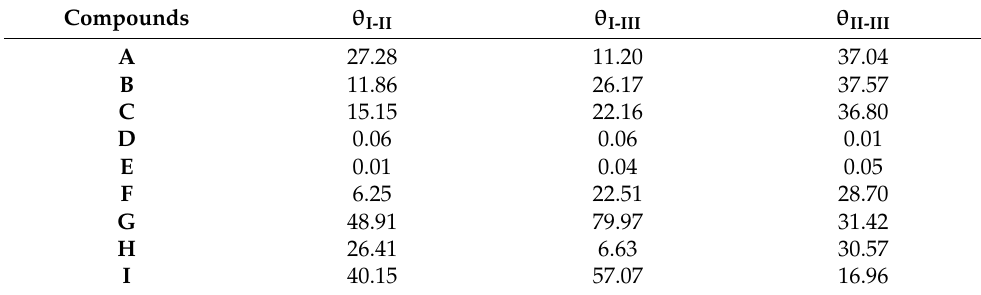
Table 2. The estimated twist angles for A , B , C , D , E , F , G , H , and I compounds.